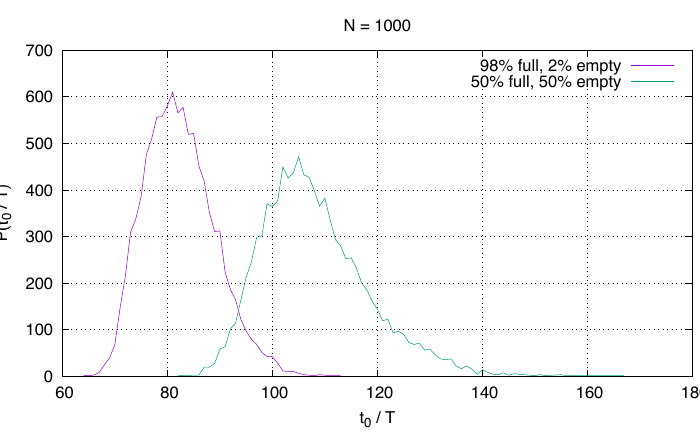
the figure more clear) is more than 40 times worse than the optimal one ( (cid:104) t 0 (cid:105) (cid:39) 42 T and